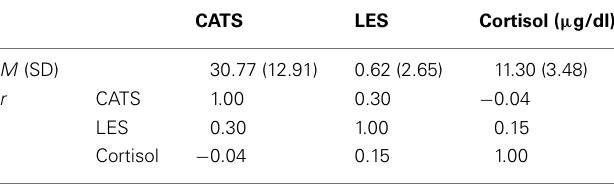
Table 1 | Summary of averaged self-report and cortisol data, and correlation coefficients ( r ) among these measurements.